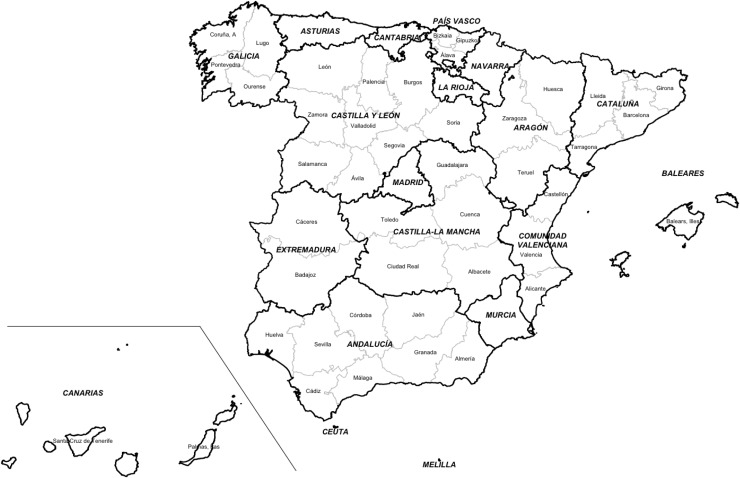
Regional and provincial administrative distributions within Spain.